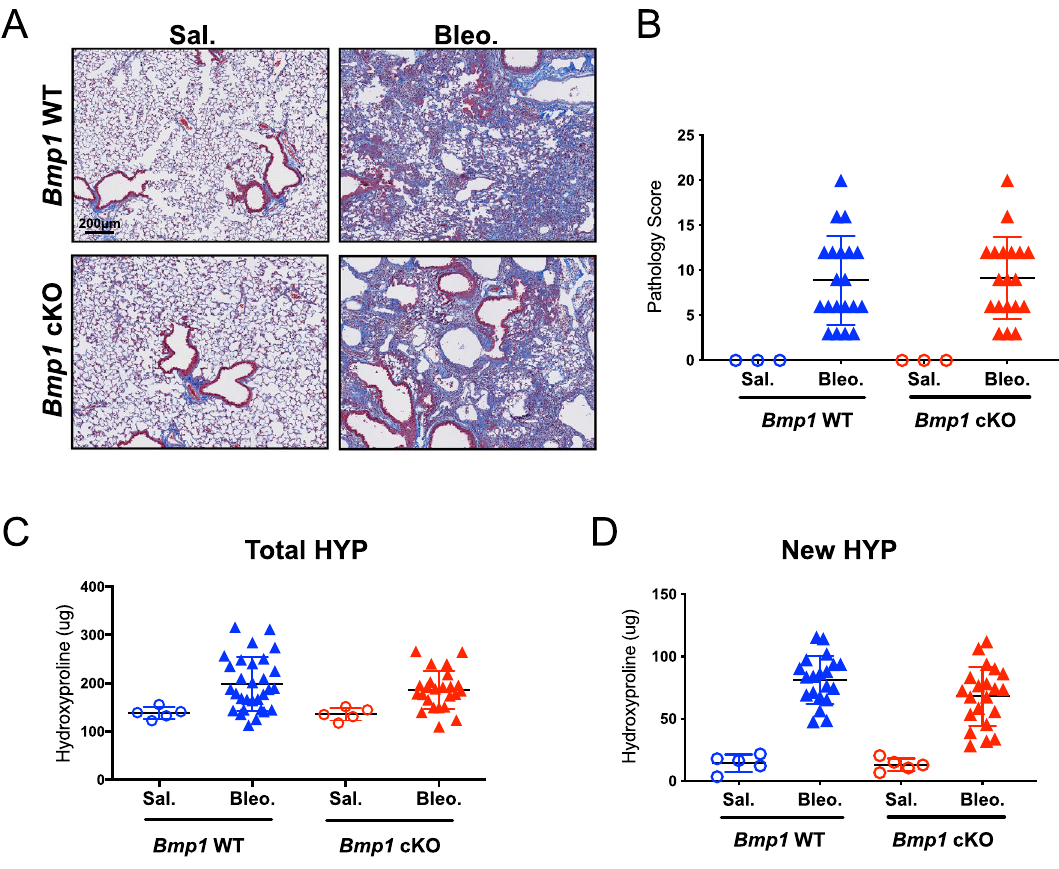
Figure 4. Bmp1 cKO mice are not protective against bleomycin-induced lung fibrosis. Representative images of trichrome histology staining ( A ) in lung tissues with quantification of fibrosis lesion ( B ). Quantification of fibrosis by total hydroxyproline ( C ) and newly synthesized hydroxyproline ( D ). Bmp1 WT: Saline n = 5, bleomycin n = 30; Bmp1 cKO: saline n = 5, bleomycin n = 21. Data represents mean ±